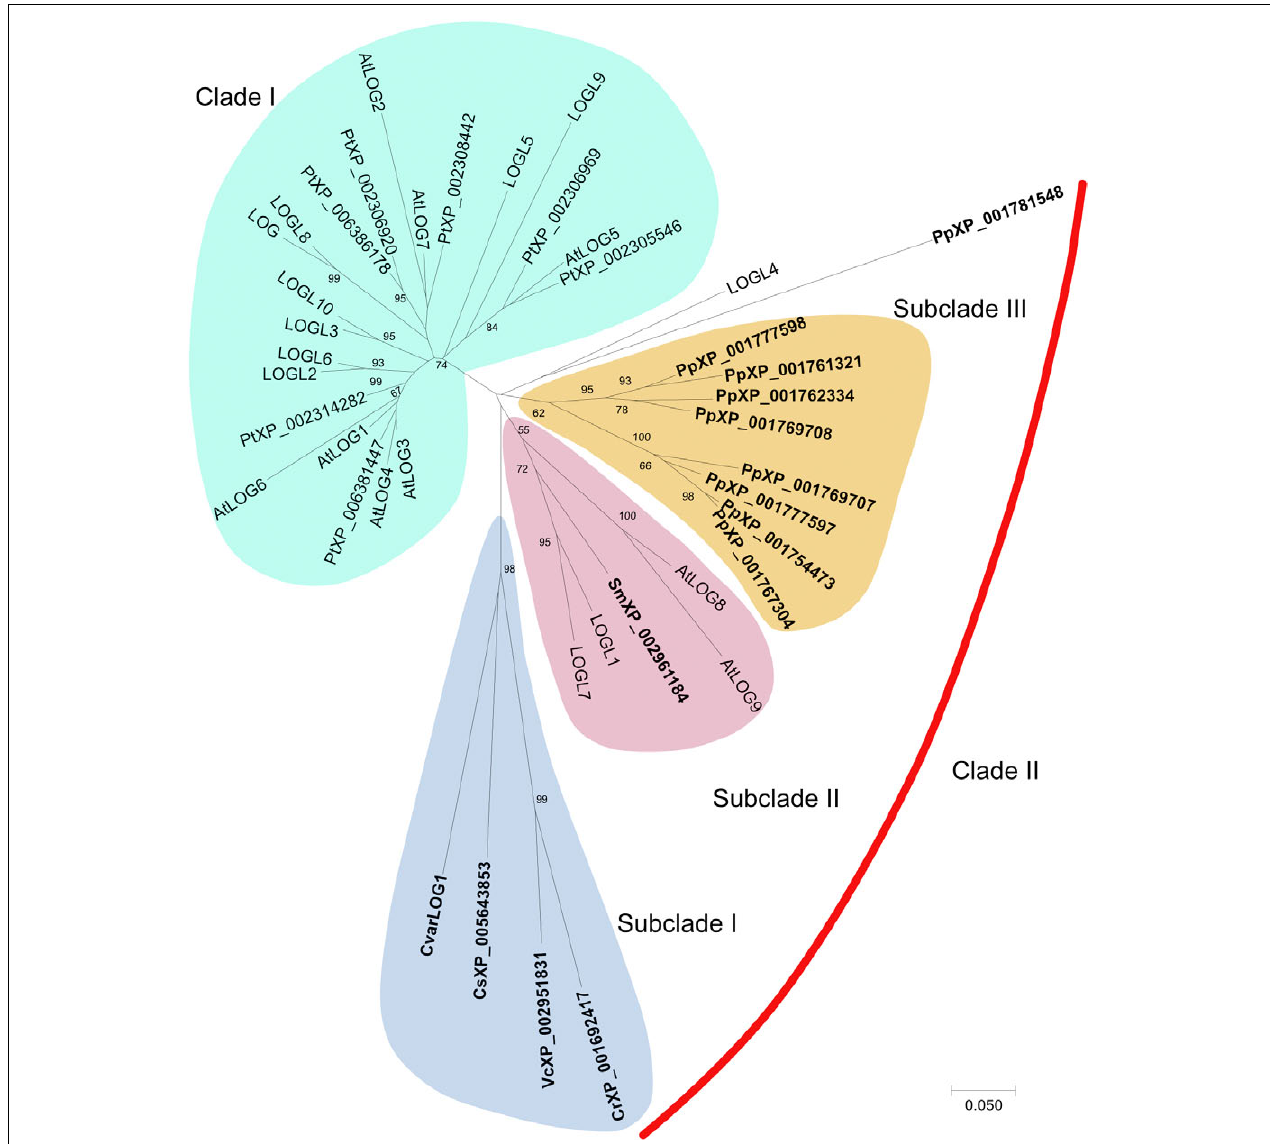
FIGURE 1 | Unrooted phylogenetic tree of CvarLOG1 and homologs in seed plants Arabidopsis (At), rice (Os), Populus trichocarpa (Pt), and non-seed plants such as Selaginella moellendorffii (Sm), Physcomitrella patens (Pp), Coccomyxa subellipsoidea (Cs), Volvox carteri (Vc), and Chlamydomonas reinhardtii (Cr). Full-length protein sequences of all the LOG homologs were obtained from protein databases. The phylogenetic tree was constructed in the MEGA 7.0 program (http://www.megasoftware.net) using the neighbor-joining method. The phylogenetic tree was built with 1,000 bootstrapping replicates. The bootstrap values of 50% and above are indicated on the tree. The scale bar represents 0.05 amino acid substitutions per site. The non-seed LOG proteins are highlighted in